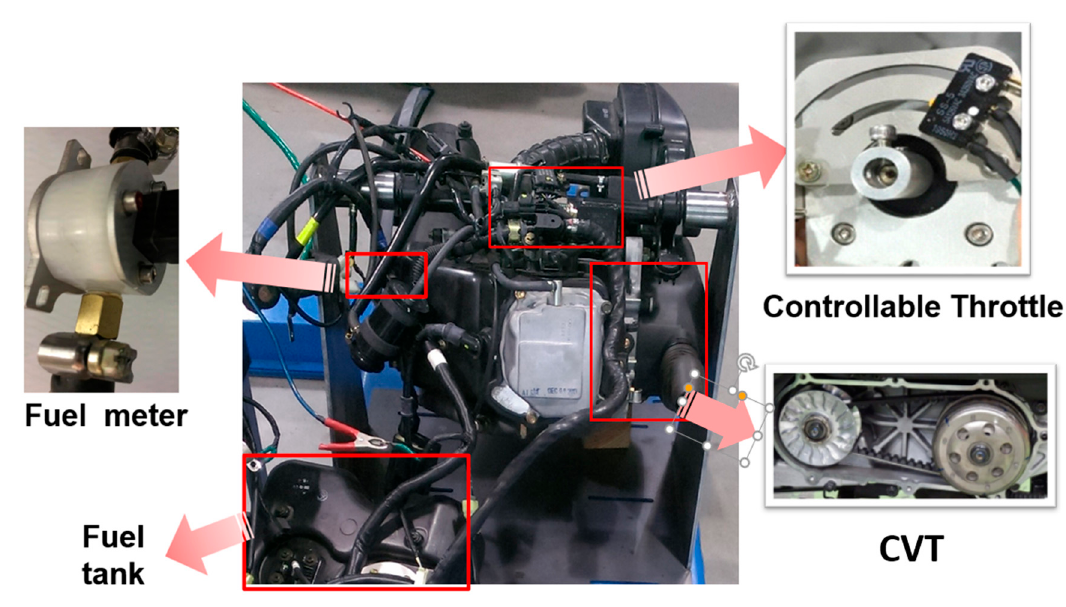
Energies 2019 , 12 , x FOR PEER REVIEW Figure 5. Key components of engine power system. Figure 5. Key components of engine power system.